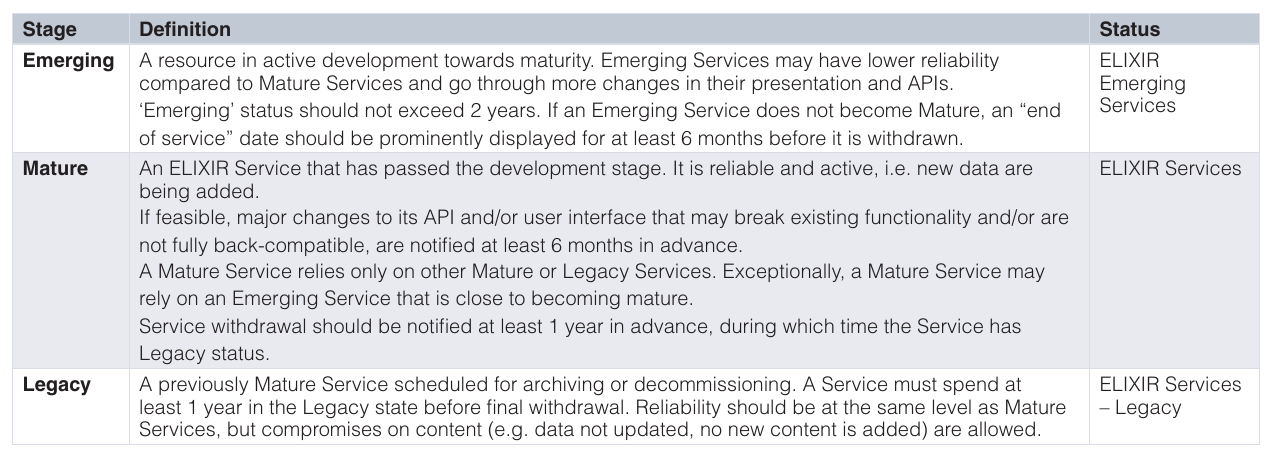
Table 1. Stages of the technical life-cycle of ELIXIR